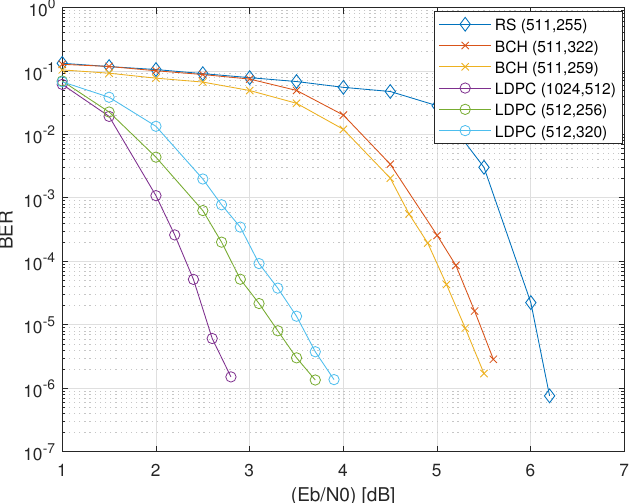
Figure 10. Error correction performance of the experimental